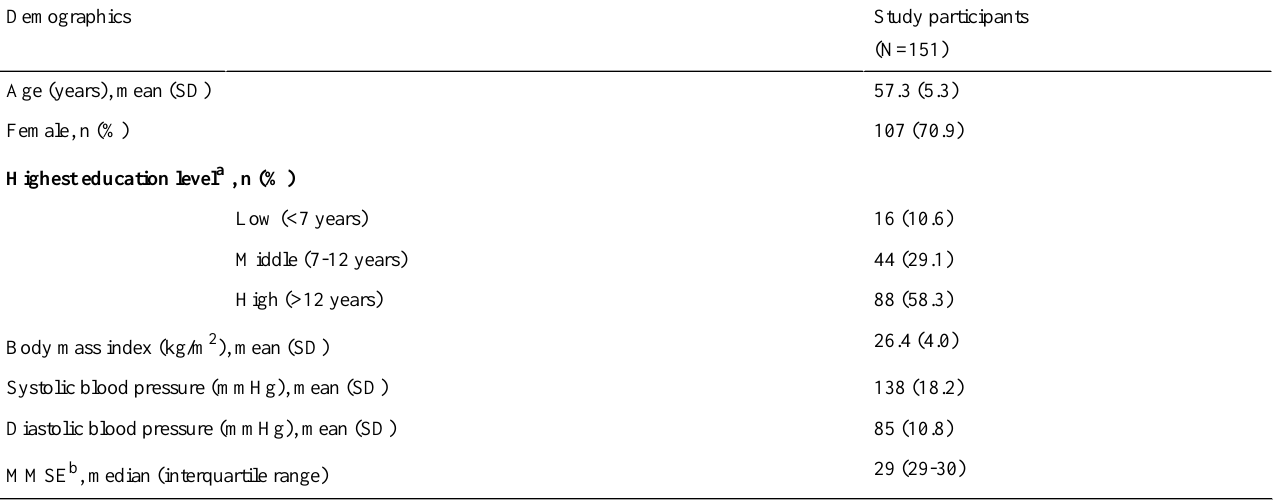
Table 2. Baseline characteristics of study